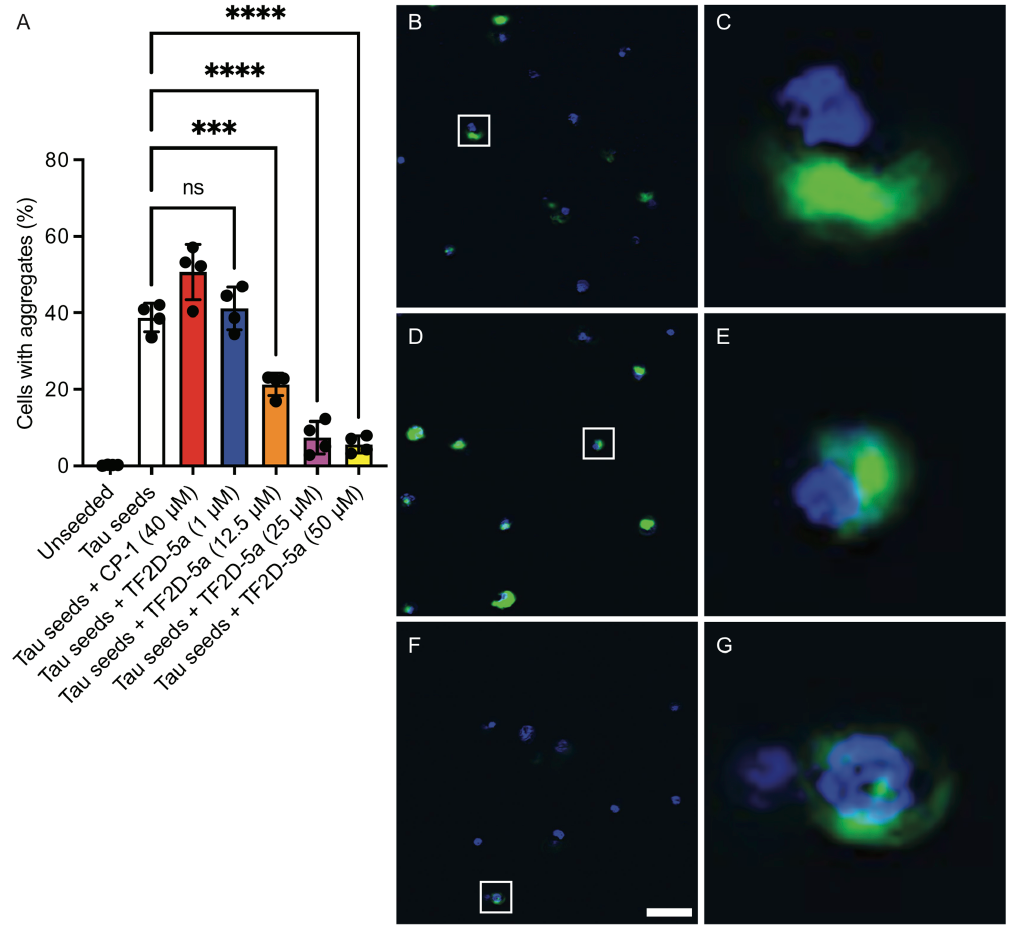
Figure 13. TF2D-5a inhibits tau aggregation in cells. In order to compare the abiliy of TF2D-5a and CP-1 to inhibit tau aggregation without interference from potentially different cell permeabilities, we used lipofectamine for cell transfection, as described in the Methods Section. ( A ) TF2D-5a and the negative-control D-peptide CP-1 were tested for their ability to inhibit tau aggregation in tauK18(LM)-YFP cells. “ns” abbreviates the expression “non significant”. ( B ) In contrast to unseeded cells, which did not harbor any tau aggregates at day three after plating, seeding with sonicated tau fibrils induced aggregation in approximately 40% of cells after three days of incubation. ( D ) A three-day treatment with the negative-control D-peptide CP-1 did not inhibit tau aggregation. ( F ) In contrast, treatment with increasing concentrations of TF2D-5a led to a concentration-dependent reduction in the number of cells with tau aggregates, which was significant at 12.5 µ M and further reduced tau aggregation at 25 µ M and 50 µ M TF2D-5a. Panels ( C , E , G ) represent magnifications of cells indicated by white rectangles in panels ( B , D , F ), respectively. The scale bar represents 50 µ m for panels ( B , D , F ), and 5 µ m for panels ( C , E , G ). Significance was calculated using one-way ANOVA followed by Dunnett’s multiple comparisons test. Three asterisks denote a p value less than 0.001 and four asterisks a p value less than